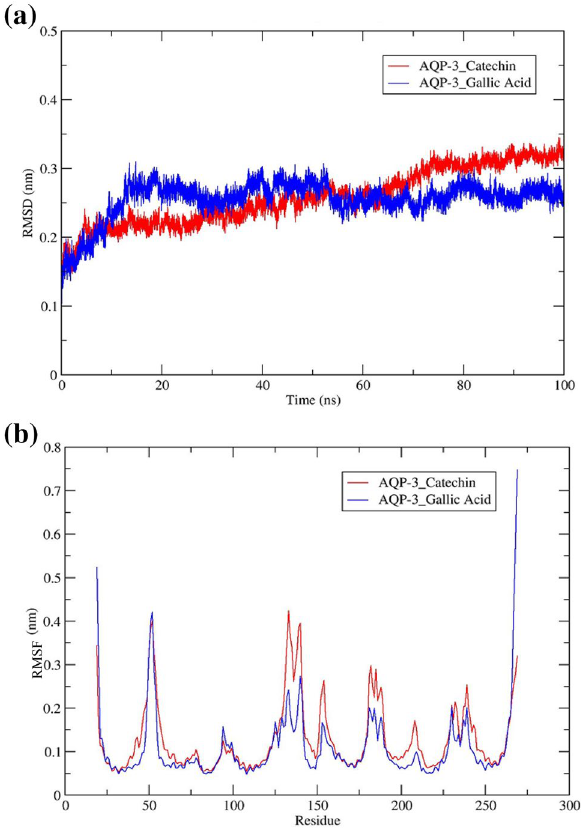
Figure 11. Average ( a ) RMSD and ( b ) RMSF for AQP-3-ligands (gallic acid and